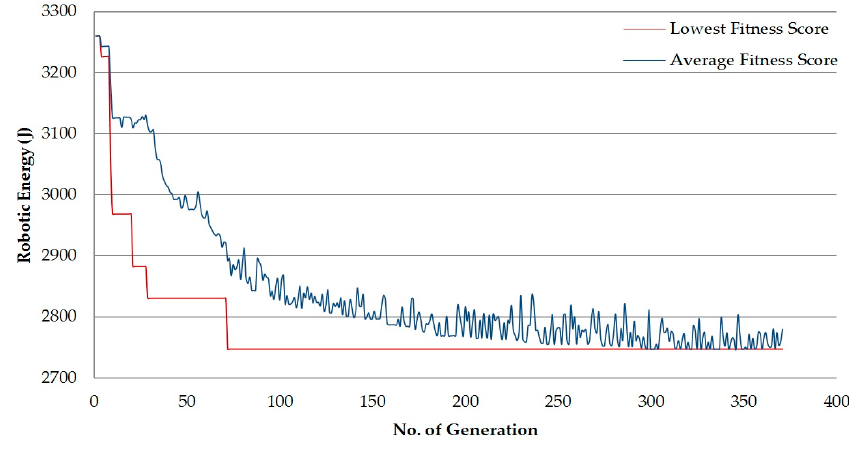
Figure 6. Performance graph of 20-node task flow (Minimise: E total ).